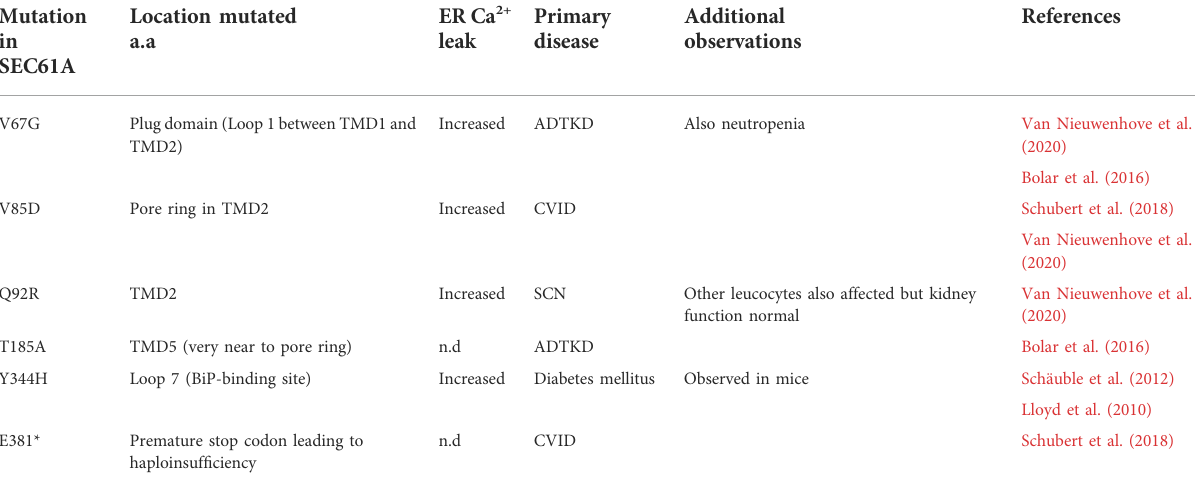
TABLE 1 Identi fi ed SEC61A1 disease mutations and their effects on the ER Ca 2+ leak. Description of SEC61A mutations leading to various diseases affecting kidney function, immunological behavior and/or metabolism, with special attention to the structural and functional consequences for the ER Ca 2+ leak. TMD2 forms part of the lateral gate, while the pore ring is the name of the central constriction of Sec61 α , which in its closed conformation is occupied by Loop 1, called the plug